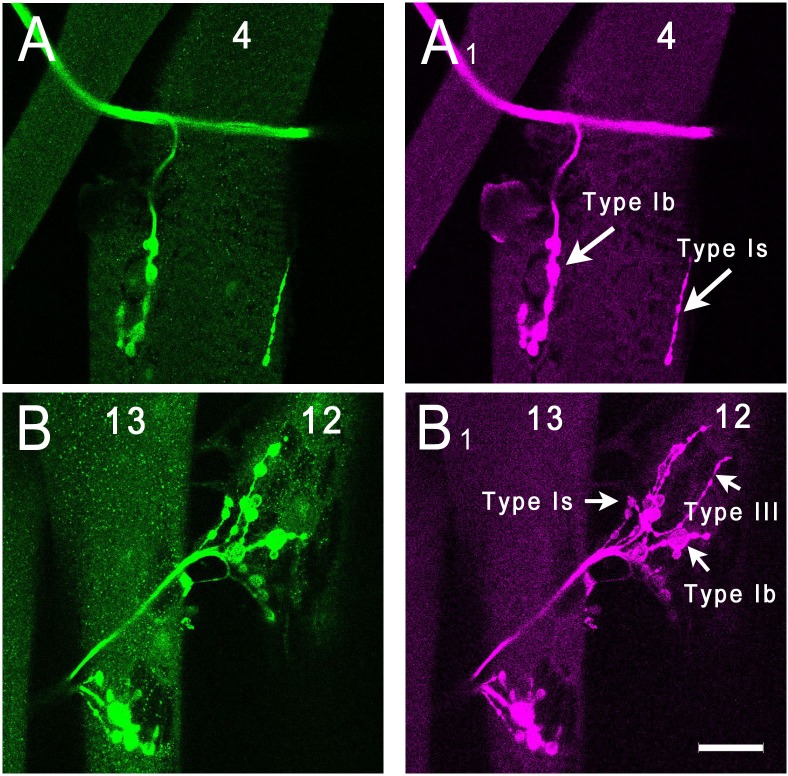
Analysis of side-VI expression patterns in larvae.Side-VI-T2A-GAL4 > eGFP third instar larvae were dissected and stained with anti-GFP (green) and anti-HRP (magenta) to visualize neuronal membranes. GFP staining was observed on motor axons and NMJs. GFP channel (A) and HRP channel (A1) of muscle 4. Arrows denote Type Ib and Type Is arbors on muscle 4. GFP channel (B) and HRP channel (B1) of muscles 12 and 13. Arrows denote Type Is, Type Ib and Type III branches of the muscle 12 NMJ. The punctate green staining on muscles 12 and 13 may indicate that there is residual expression of side-VI in these muscles at third instar. Scale bar, 25 µm.